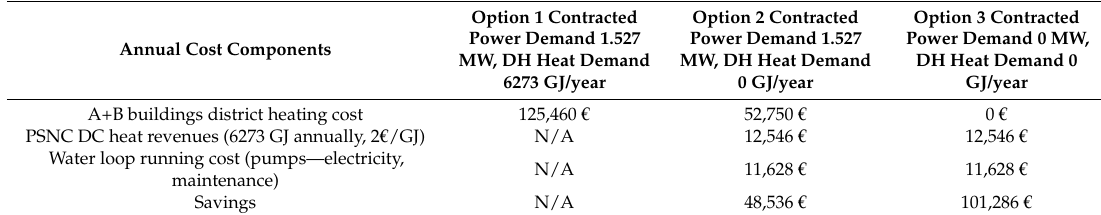
Table 4. Operational costs analysis for the three heat reuse options considered.